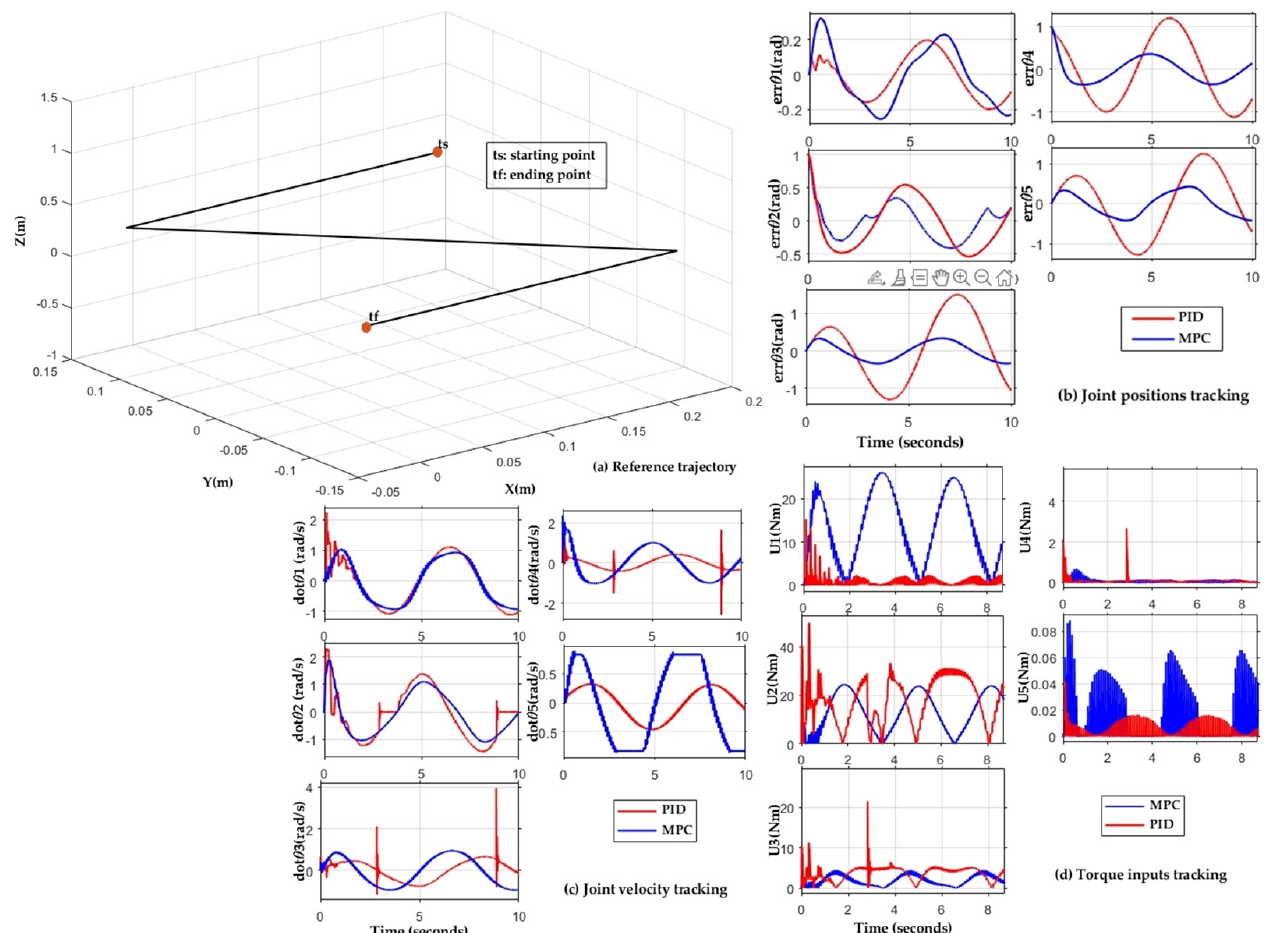
Figure 11. Simulation results related to the N-shaped reference trajectory.